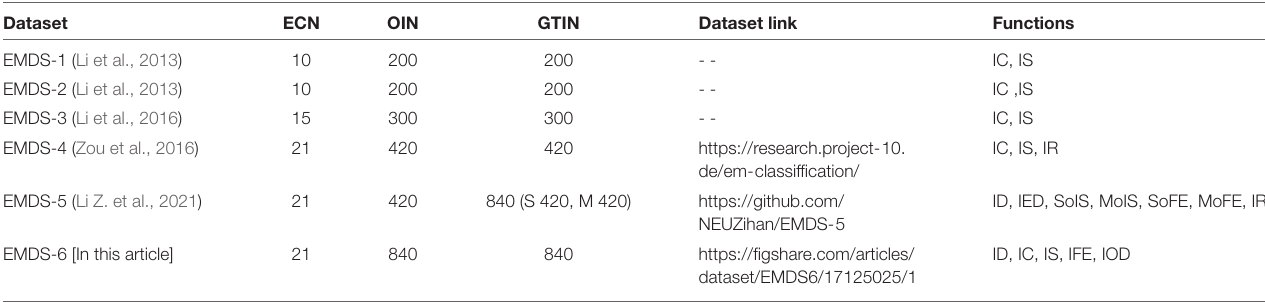
TABLE 13 | EMDS history versions and latest